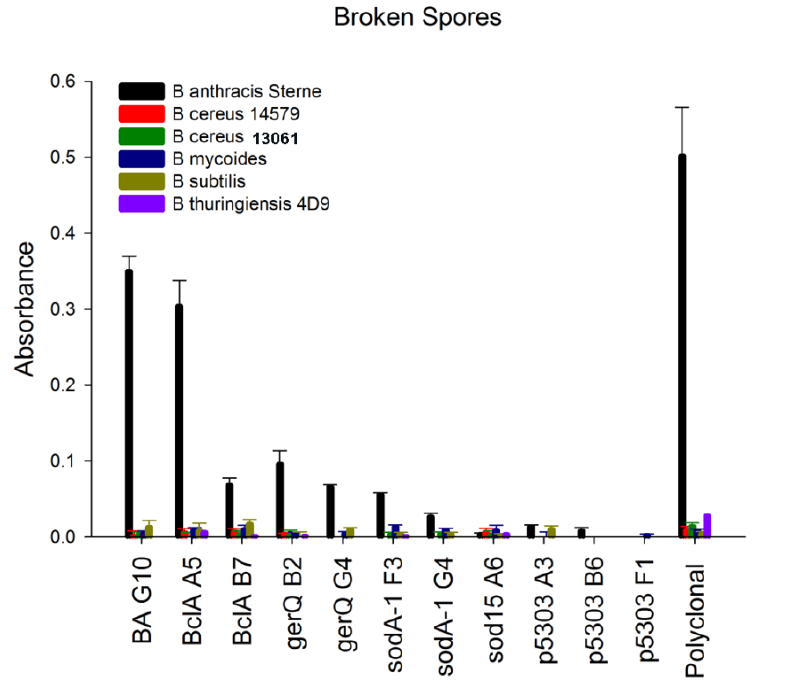
Figure 5. Specificity assay. Direct binding ELISA of the isolated sdAb to broken spores from B. anthracis Sterne and other Bacillus species. Binding of biotinylated sdAbs was detected with an HRP-conjugated